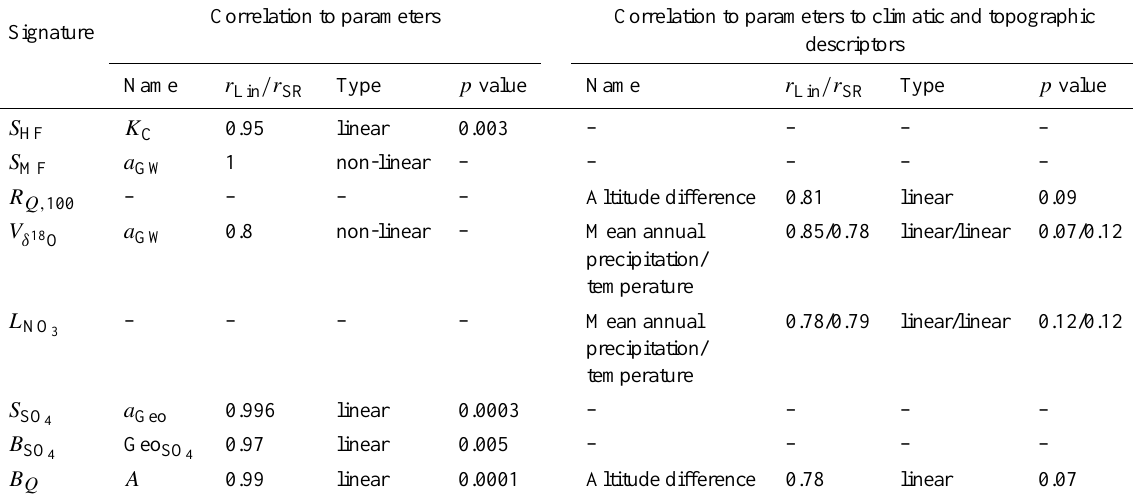
Table 7. Summary of correlations between system signatures and model parameters, and between system signatures and climatic and topo- graphic